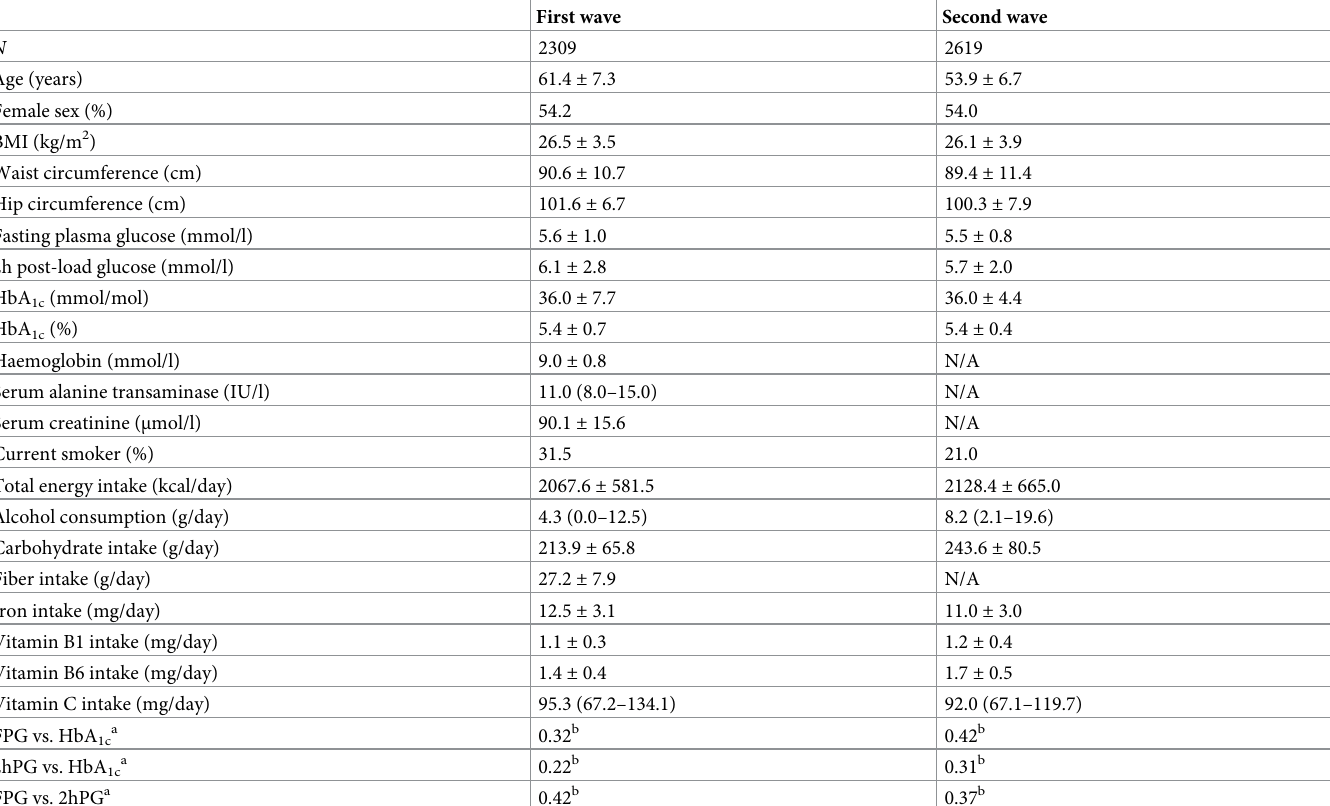
Table 1. Population characteristics and Spearman correlations of the participants of the Hoorn